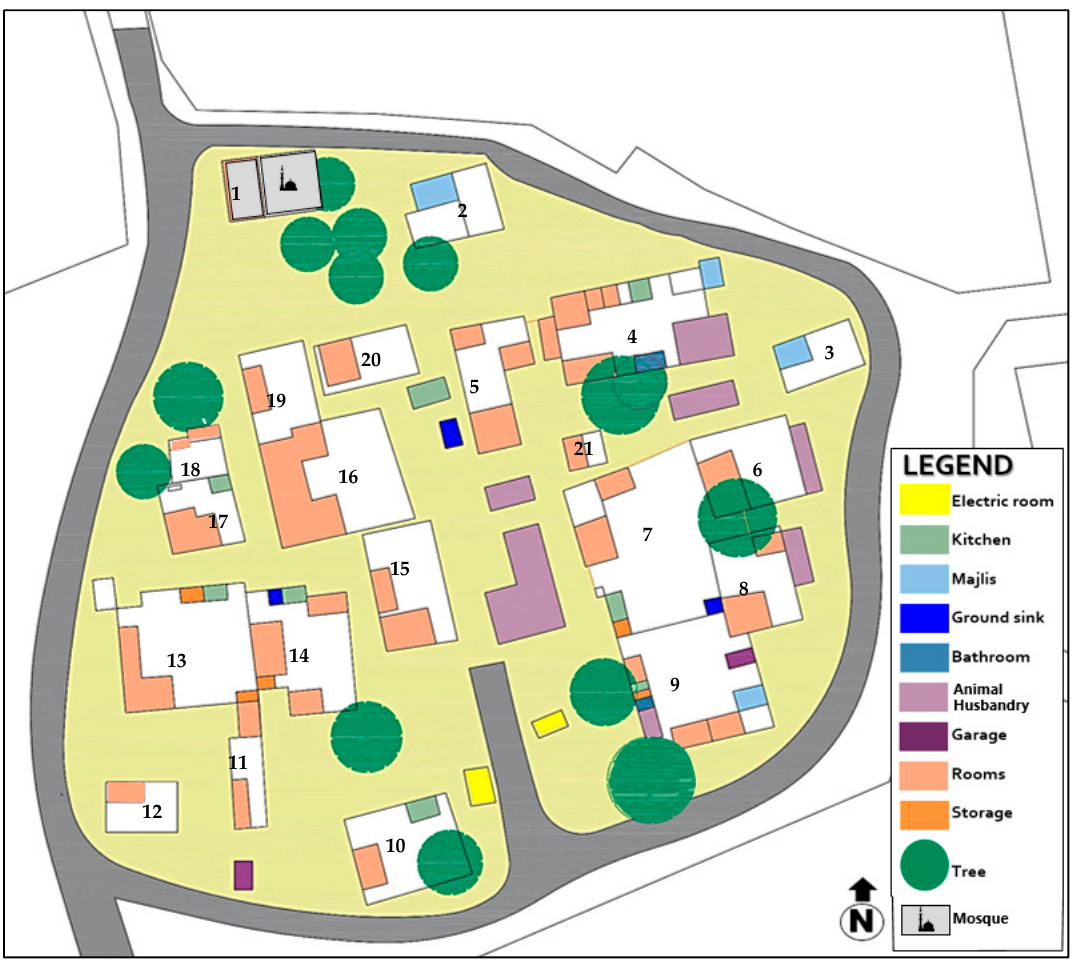
Figure 5. Land use map of the village of Tinbak with assigned numbers for discussion in the text. The map shows several points, One: Each house has a courtyard that can be used for additional rooms to accommodate the increasing number of family members; Two: The low height of fences of the courtyards, with an average elevation of 140 cm, makes the open public areas look like an extension to the courtyard, the private space; Three: The village lack greenery; Four: The mosques are set at the village’s periphery to prevent outriders using the mosques from penetrating the private domains of the village.